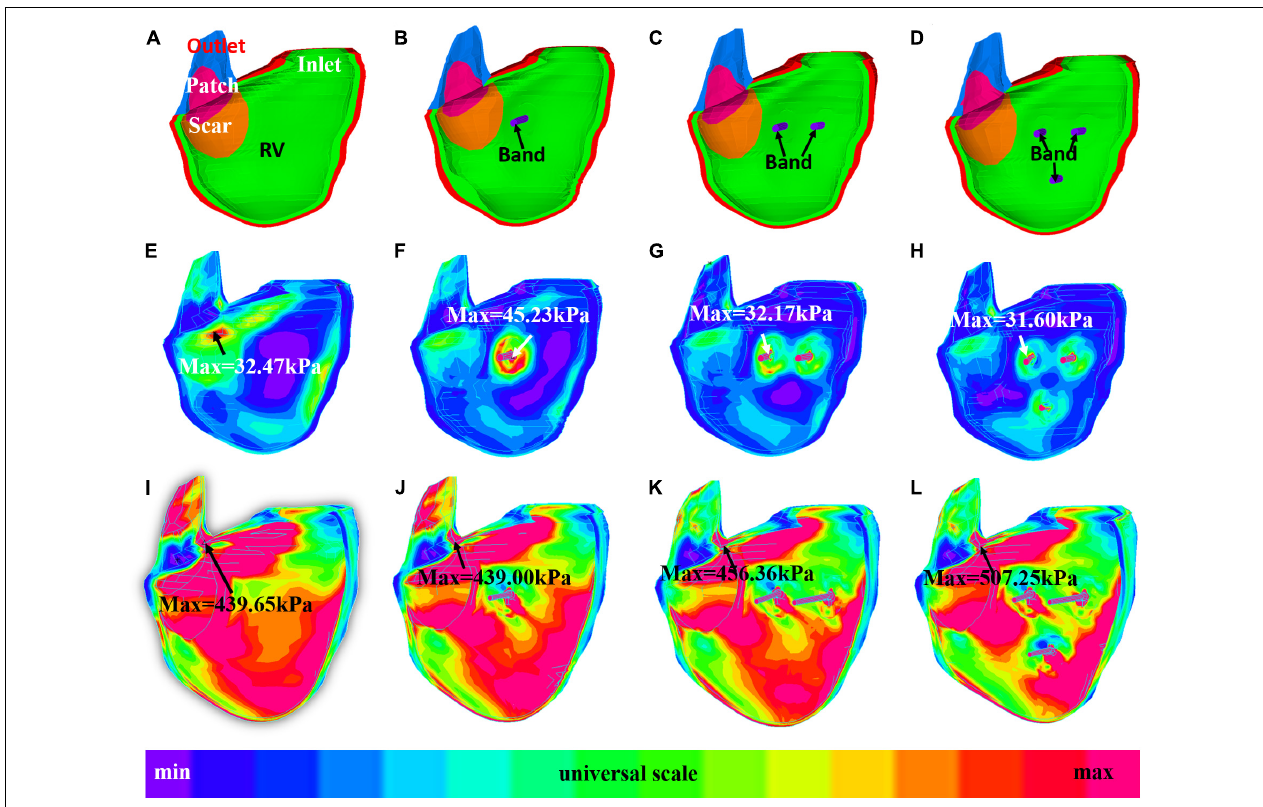
FIGURE 6 | Stress plots of patient 5 from the no-band model and three active band models with band contraction ratio of 20%. (A) Model with no band, zero load. (B) Plan A: model with one band, zero load. (C) Plan C: model with two bands, zero-load. (D) Plan E: model with three bands, zero load. (E) Model with no band, begin filling. (F) Plan A: model with one band, begin filling. (G) Plan C: model with two bands, begin filling. (H) Plan E: model with three bands, begin filling. (I) Model with no band, begin ejection. (J) Plan A: model with one band, begin ejection. (K) Plan C: model with two bands, begin ejection. (L) Plan E: model with three